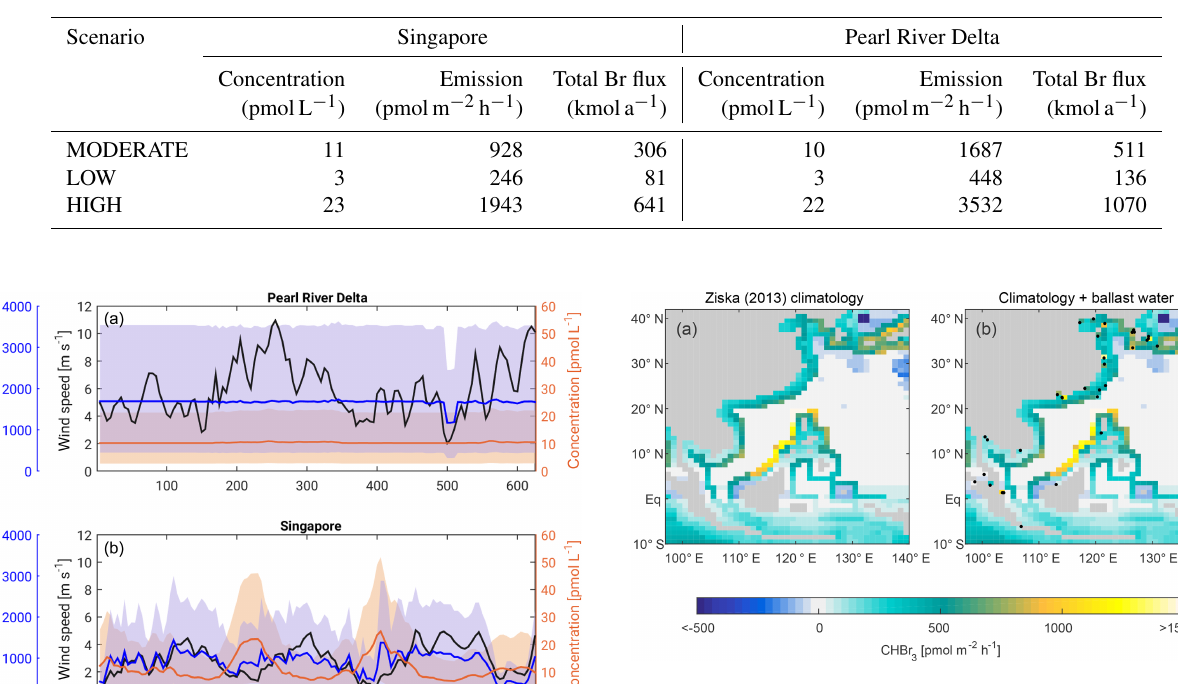
Figure 10. (a) Modelled bromoform emission rates updated from Ziska et al. (2013). (b) Same as (a) with additional anthropogenic emission rates calculated as 90% of total bromoform release from ballast water treatment at each harbour. Black dots indicate the loca- tion of all harbours from the modified world port ranking in South- east